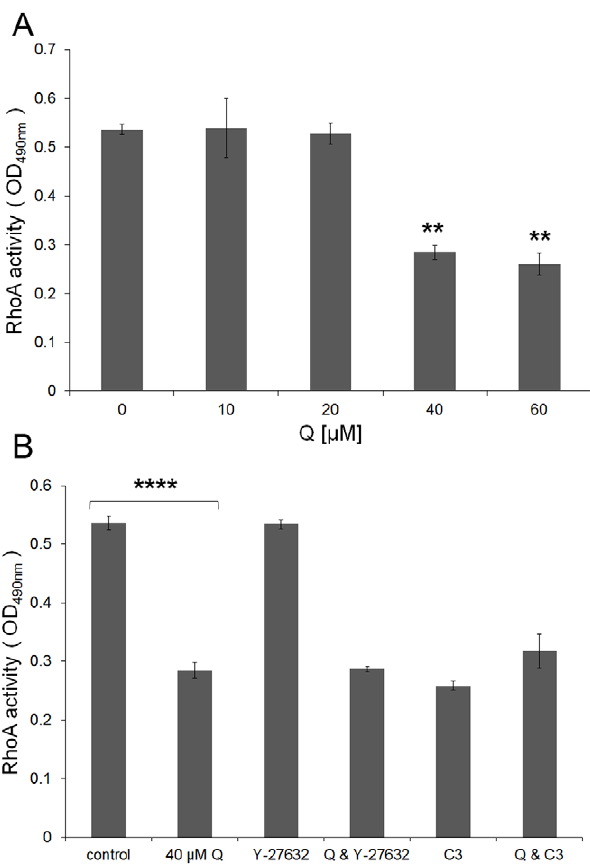
Figure 4. Isoquercitrin inhibits RhoA activity. Cells were maintained for 48 hours in the presence/absence of isoquercitrin and absorbance at OD 490 nm was calculated for the cell lysates according to Rho G-Lisa assay. A, Isoquercitrin dose dependent graph; B, Effects of isoquercitrin on RhoA activity alone and in combination with Rho/ROCK inhibitors (n=3, one-way ANOVA, ** p , 0.01; **** p , 0.0001). Data are shown as means 6 s.e.m.